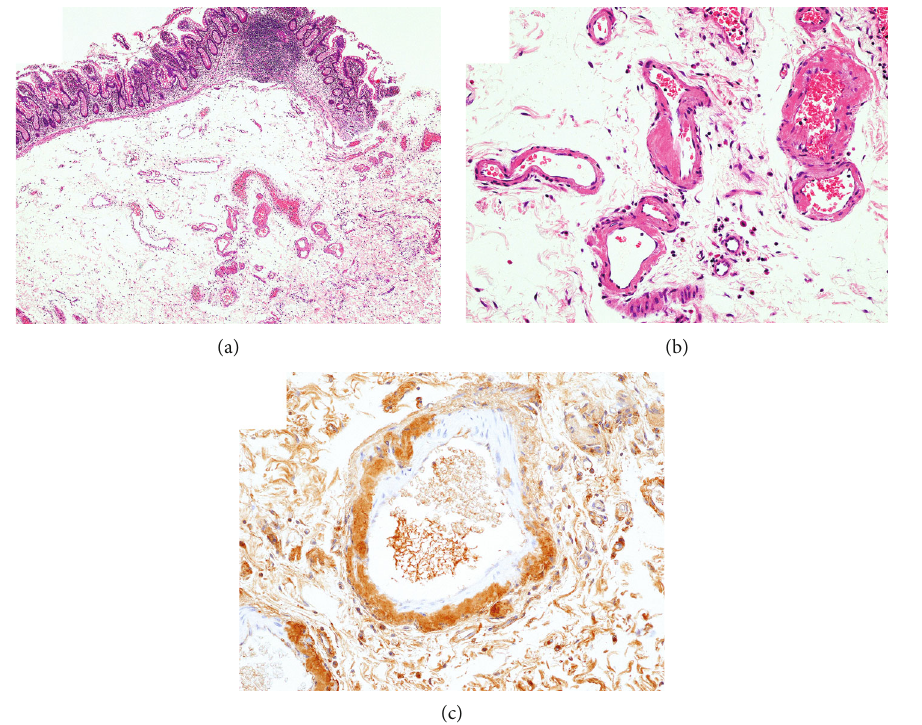
Figure 1: (a) A low-power view of the ileal biopsy specimen (hematoxylin and eosin stain; original magni fi cation × 40). (b) Amorphous eosinophilic deposits are apparent on the vessel wall (hematoxylin-eosin stain, original magni fi cation × 200). (c) Immunohistochemically, deposits show positive staining for β 2-microglobulin (original magni fi cation × 200).